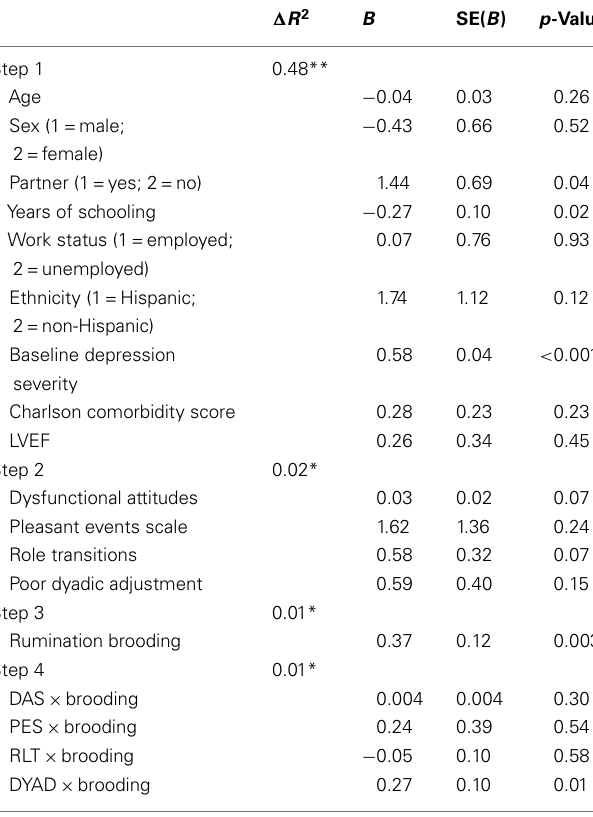
Table 4 | Hierarchical Regression summary of the effect of baseline psychosocial vulnerabilities, rumination as an independent predictor and rumination as an amplifier on 3month depression severity,